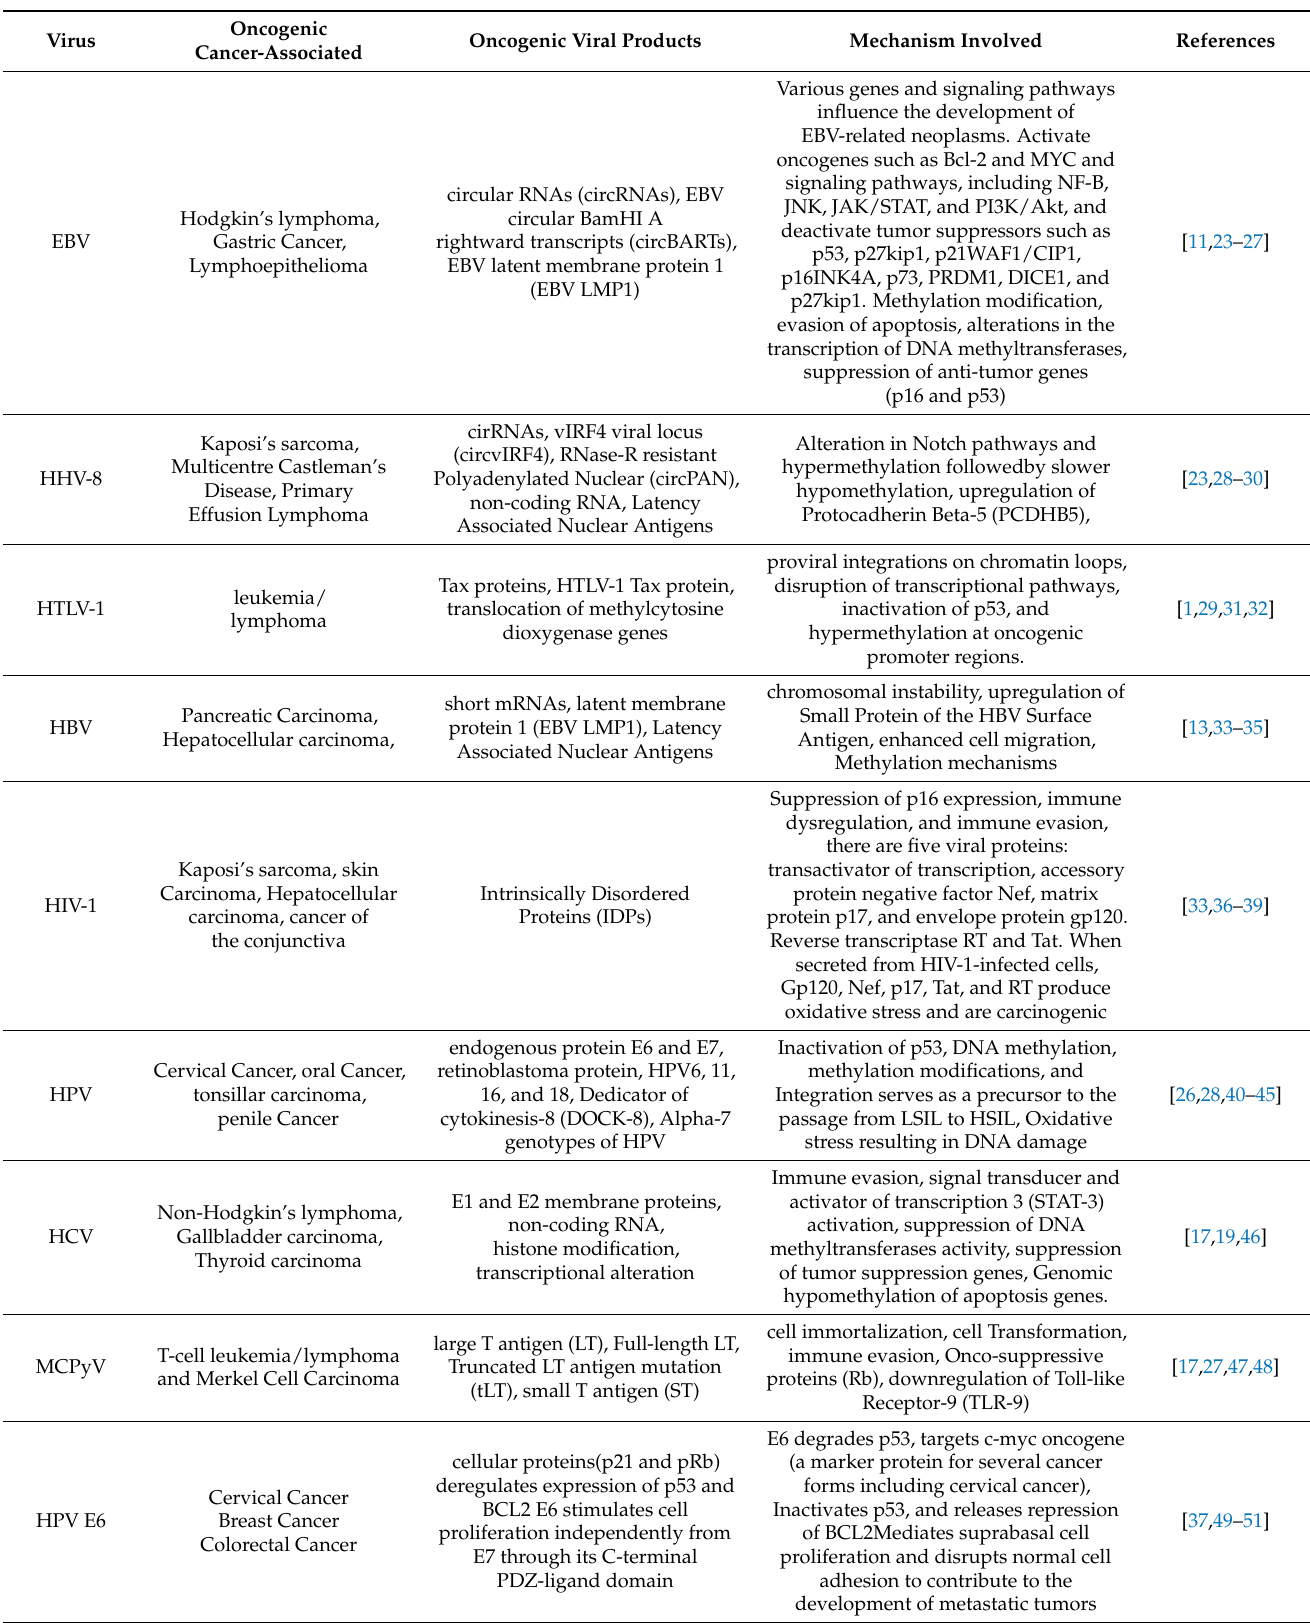
Table 1. Viruses are classified as group I carcinogenic viruses per IARC, a summary of carcinogenic determinants and associated cancers caused by these oncogenic